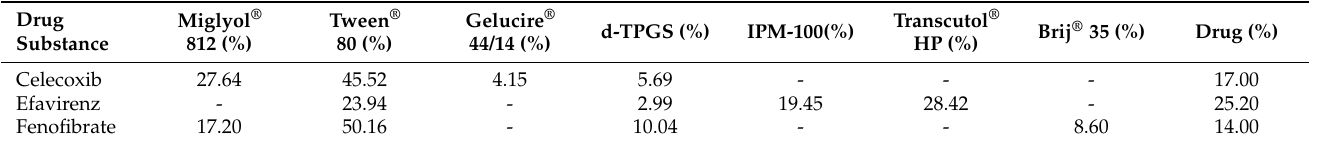
Table 1. Composition of Liquid-SNEDDS (L-SNEDDS) incorporating celecoxib, efavirenz or